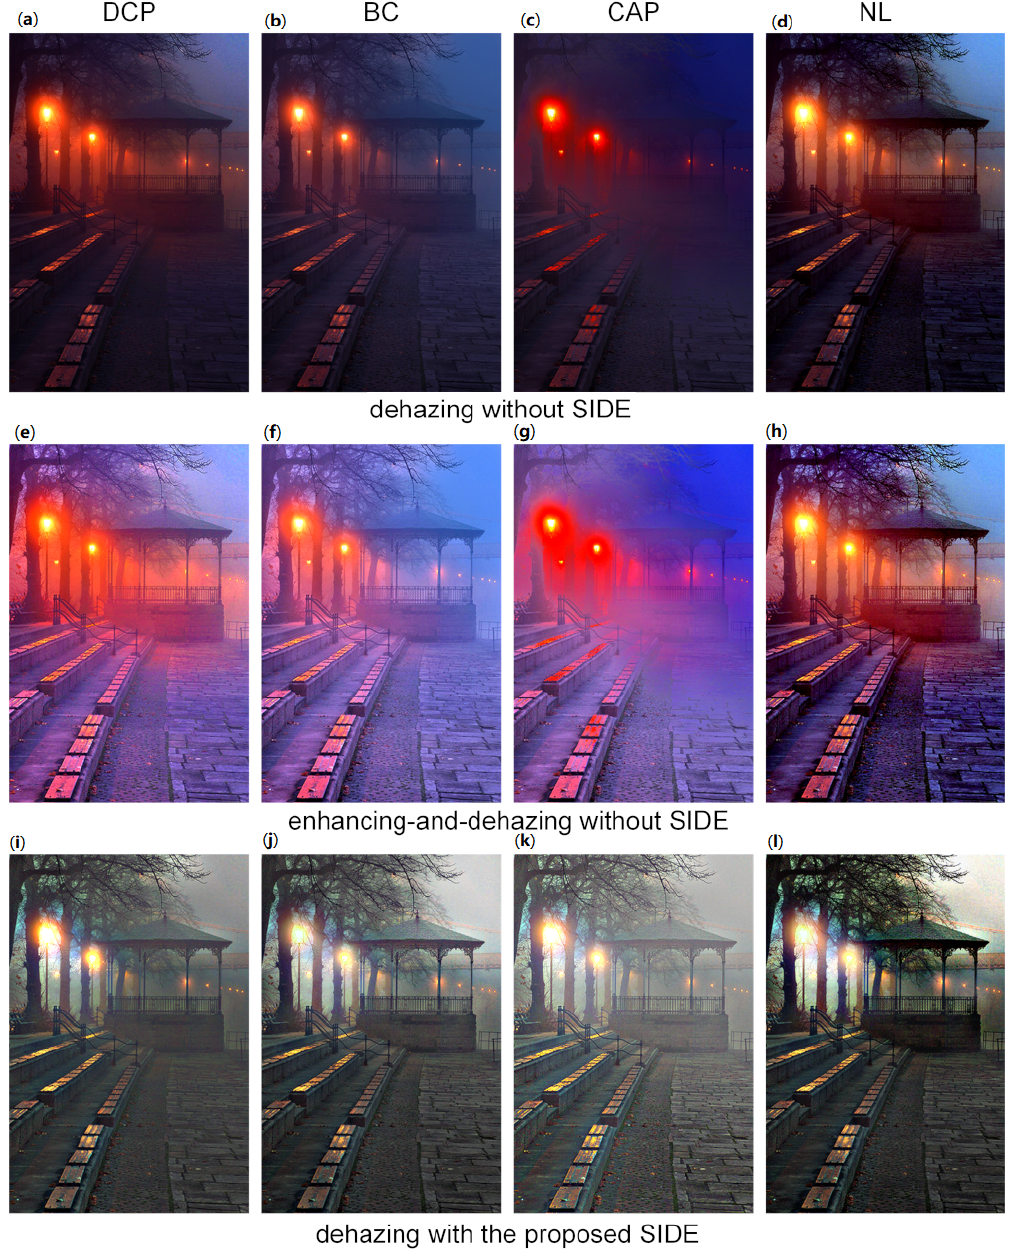
Figure 5. Illustration of the proposed SIDE. ( a – d ): results of conventional daytime dehazing methods without SIDE; ( e – h ): results with the enhancing-and-dehazing flow (enhanced by LIME [17]); ( i – l ): results of corresponding methods with the proposed SIDE. From left to right: dark channel prior (DCP) [2], boundary constraint method (BC) [4], Color Attenuation Prior (CAP) [6] and Berman’s non-local method (NL)